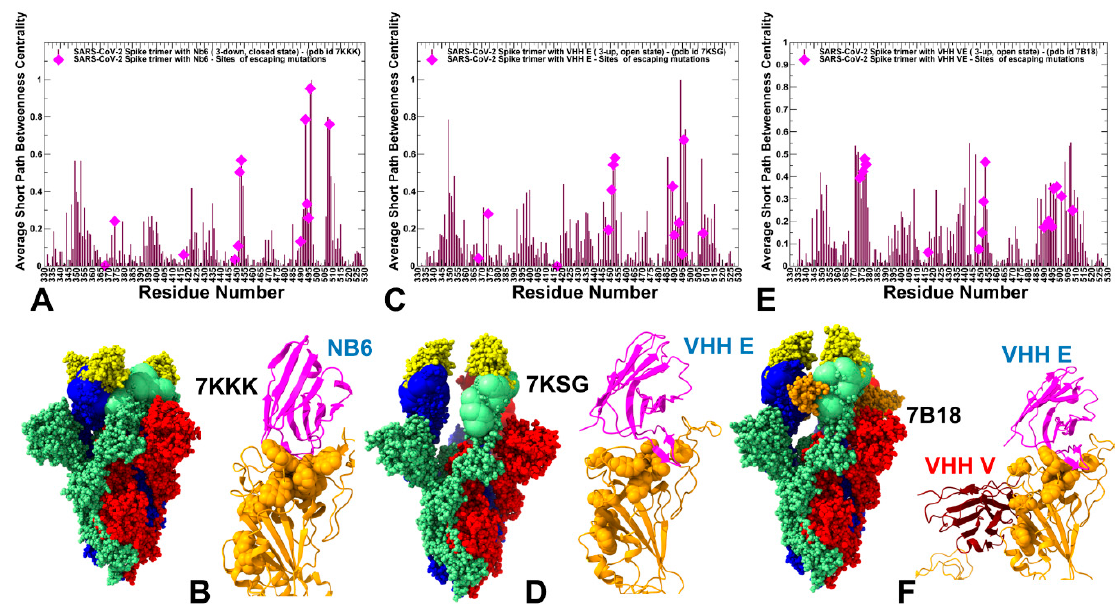
Figure 9. Network centrality analysis of the SARS-CoV-2 S trimer complexes with nanobodies. ( A ) The ensemble-averaged short path betweenness centrality for the SARS-CoV-2 S trimer in the complex with Nb6 nanobody, pdb id 7KKK ( A ), S trimer in the complex with VHH E nanobody, pdb id 7KSG ( C ), and S trimer in the complex with VHH E/VHH V nanobody, pdb id 7B18 ( E ). The residue- based profiles are shown for the S trimers are shown in maroon-colored filled bars. The sites of escaping mutations for nanobody binding are highlighted in blue-colored filled diamonds. ( B ) The structure of the SARS-CoV-2 S trimer in the complex with Nb6 nanobody. The S trimer is shown in full spheres with protomers A,B,C colored in light green, red, and blue, respectively. Nb6 nanobod- ies are shown in yellow spheres. The structural maps are projected onto the original cryo-EM struc- tures. The rendering of SARS-CoV-2 S structures was done using the visualization program UCSF ChimeraX [108]. The sites of escaping mutations are highlighted in large spheres colored according to the respective protomer. A closeup of the S-RBD bound to Nb6. S-RBD is in orange ribbons, and Nb6 is in magenta ribbons. The sites of escaping mutations are shown in orange spheres and corre- spond to the highlighted positions in the centrality profile. ( D ) The structure of the SARS-CoV-2 S trimer in the complex with VHH E nanobody. VHH E is in yellow spheres, and sites of escaping mutations are shown in spheres. A closeup of the S-RBD bound to VHH E with sites of escaping mutations in orange spheres. The annotations are the same as in panel B. ( F ) The structure of the SARS-CoV-2 S trimer in the complex with VHH E/VHH V nanobody. VHH E is in yellow spheres and VHH V is in orange spheres. A closeup of the S-RBD bound to VHH E/VHH V with sites of escaping mutations in orange spheres. VHH E is in magenta ribbons, and VHH V is in red ribbons. In contrast, in the S complex with bi-paratopic VHH VE nanobody, a partial redistri- bution of the network centrality distribution was detected, pointing to the reduced peaks in the RBD residues from the ACE2-binding site, while showing a moderate centrality for S-RBD core residues from the cryptic site (S371, F374, S375, F377, C379, Y380). The ob- served modulation of high centrality peaks and broadening of the distribution showed that many residues feature a moderate level of centrality. As a result, VHH VE nanobody binding can induce long-range couplings between the cryptic binding epitope and ACE2- binding site through a broader ensemble of communication paths that is less dependent on specific mediating centers and therefore may be less sensitive to mutational perturba- tions of functional residues. This suggests a plausible mechanism by which bi-paratopic nanobodies can leverage dynamic couplings to synergistically inhibit distinct binding epitopes and suppress mutational escape.